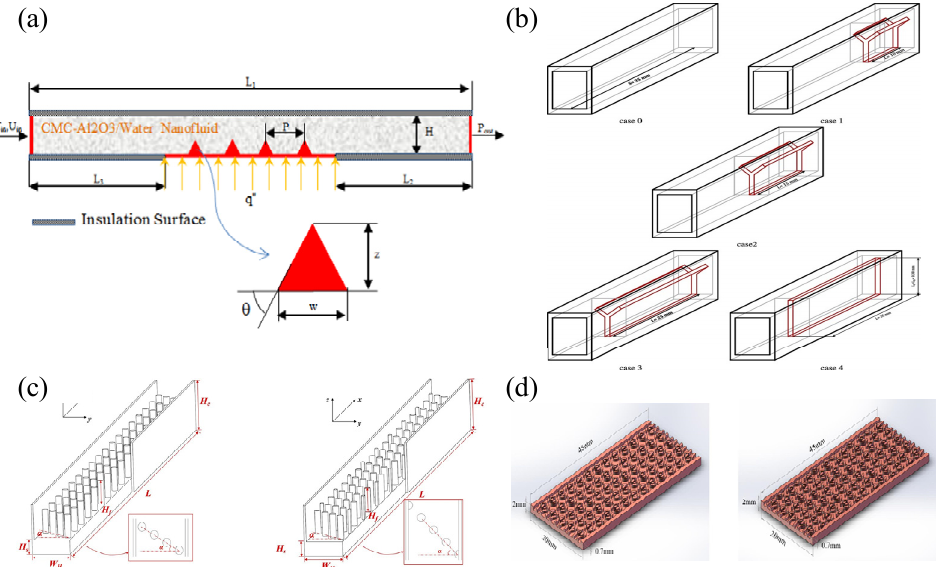
Figure 8. Schematic diagram of pin fins and microstructures microchannels: ( a ) Shamsi et al. (adapted from Ref. [34]), ( b ) Xie et al. (adapted from Ref. [35]), ( c ) Xie et al. (adapted from Ref. [32]), ( d ) Zeng et al. (adapted from Ref. [82]).